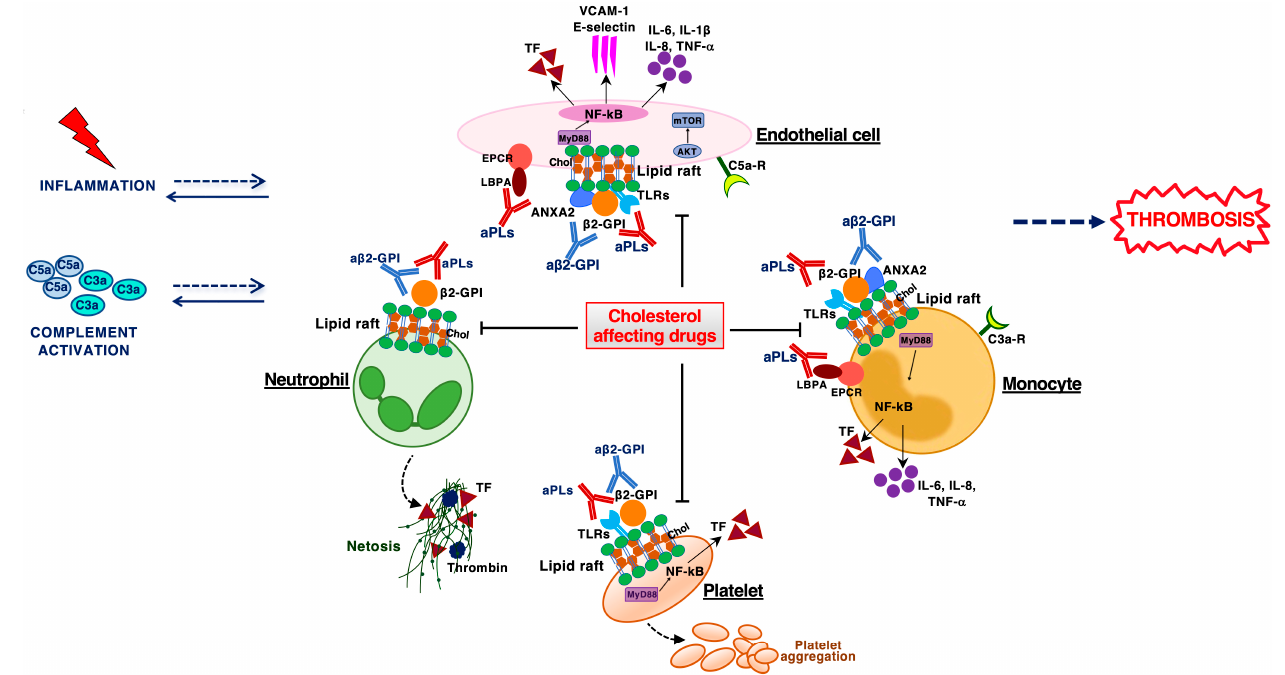
Figure 1. Pathogenetic mechanisms contributing to thrombosis in APS and possible molecular targets. Molecular mechanisms of aPLs, in particular of anti- β 2-GPI antibodies, involve the cooperation of endothelial cells, monocytes and platelets with a production of adhesion molecules, proinflammatory cytokines and tissue factor, leading to a proinflammatory and procoagulant state. Anti- β 2-GPI antibodies may also activate neutrophils by inducing the formation of NETs important to propagate inflammation and contribute to thrombosis. Inflammation and complement activation play a central role in upregulating cell activation in the pathophysiology of APS. These pathogenetic pathways underlying clinical manifestations of APS can be exploited as targets of immunomodulatory therapeutic strategies to be used in APS patients. Beta2-glycoprotein I ( β 2- GPI); Annexin 2 (ANXA2); toll-like receptors (TLRs); C3a receptor (C3a-R); C5a receptor (C5a-R); cholesterol (Chol); endothelial protein C receptor (EPCR); lyso-bis-phosphatidic acid (LBPA); myeloid differentiation factor 88 (MyD88); mammalian target of rapamycin complex (mTOR); nuclear factor-kappa B (NF- κ B); neutrophil extracellular traps (NETs); vascular cellular adhesion molecule (VCAM-1); intercellular adhesion molecule-1 (ICAM-1); tumor necrosis factor alpha (TNF- α ); tissue factor (TF); interleukin (IL).